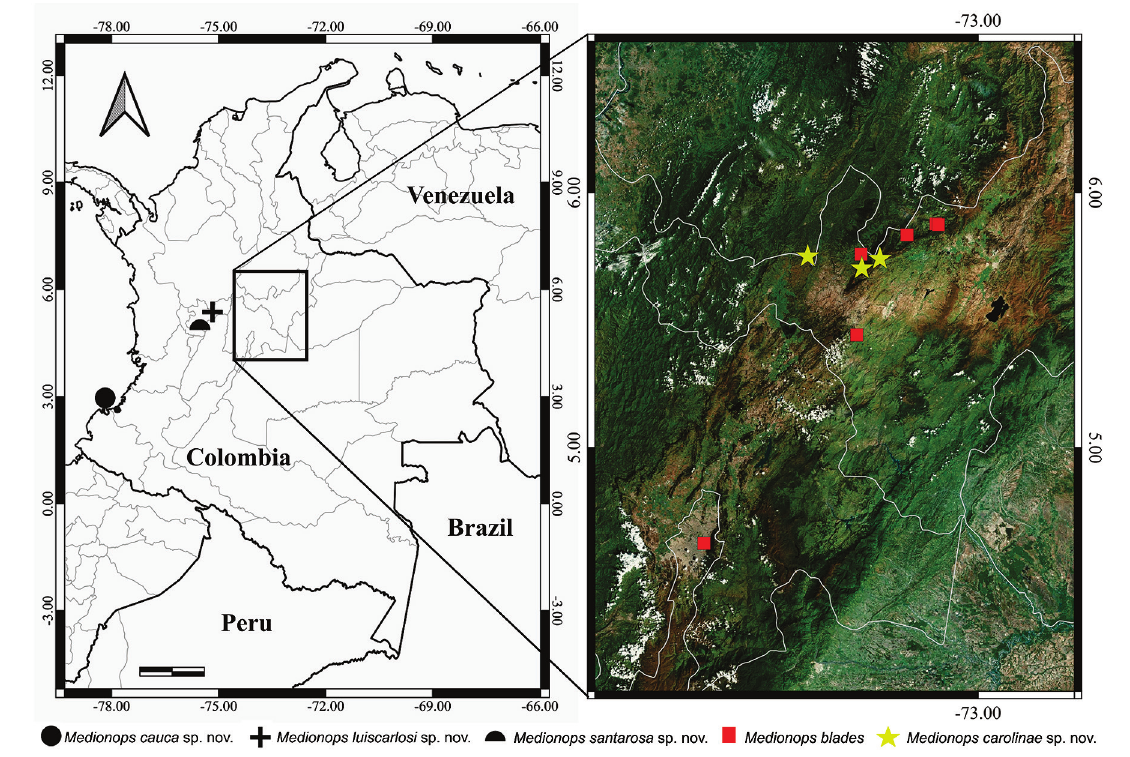
Fig. 6. Distribution map of Colombian species of Medionops Sánchez-Ruiz & Brescovit,